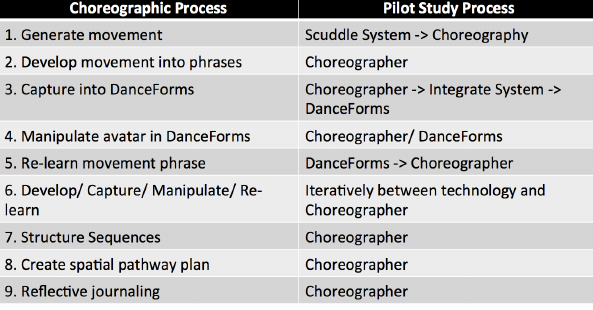
Figure 5. Comparing Choreographic Process Between Systems and the human